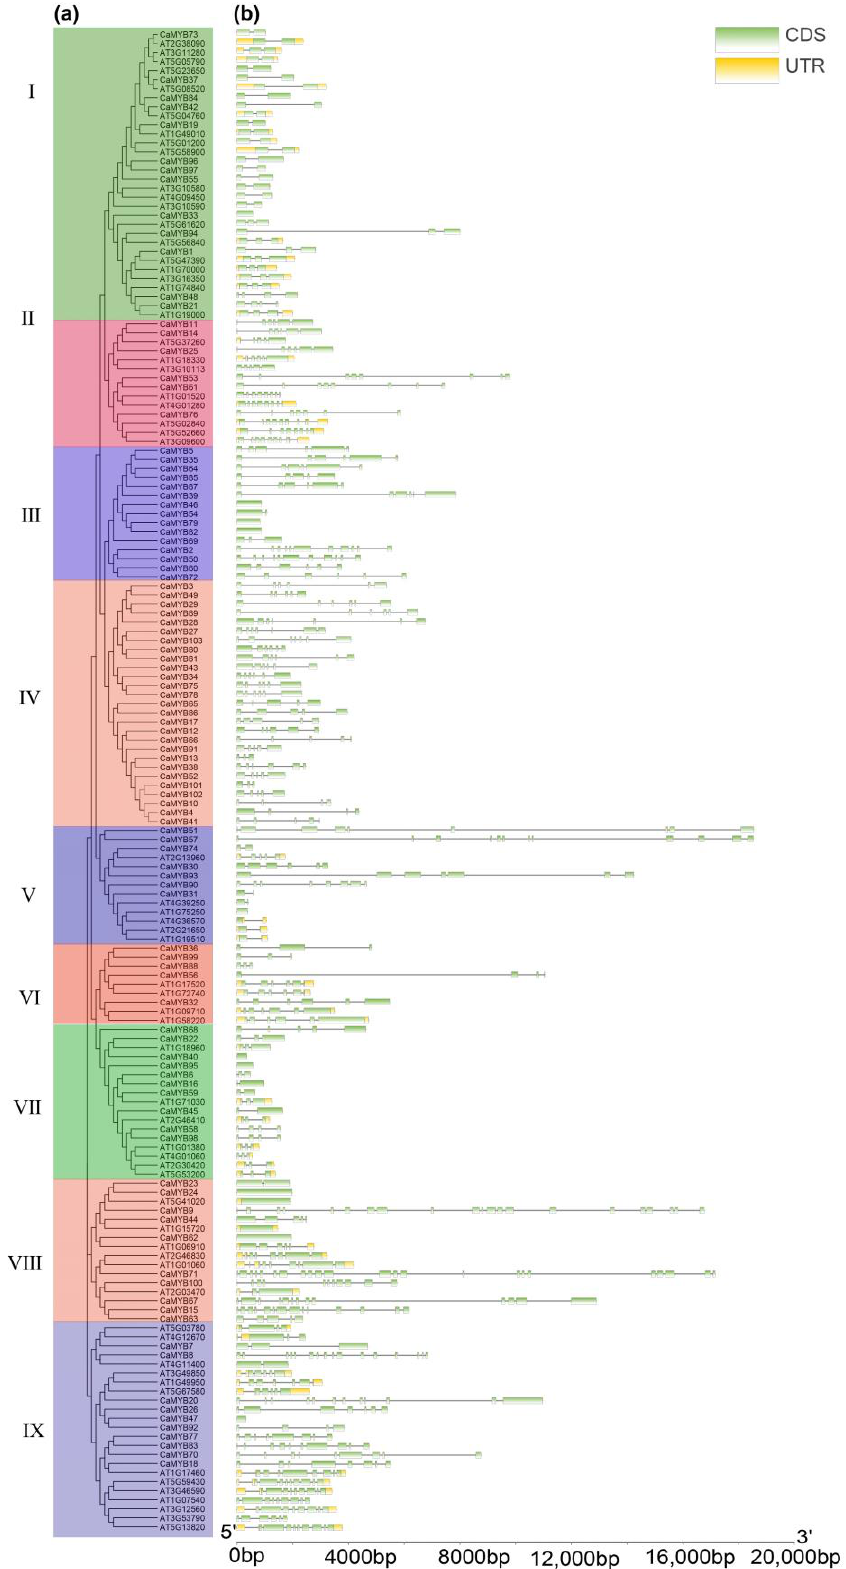
Figure 3. Phylogenetic relationship and gene structure of CaMYB-related and AtMYB-related families. ( a ) Unrooted phylogenetic tree of CaMYB-related and AtMYB-related proteins constructed using neighbor-joining method (NJ). ( b ) Gene structure. Green squares represent introns of genes, yellow squares represent uncoded UTR regions, and black lines represent exons.